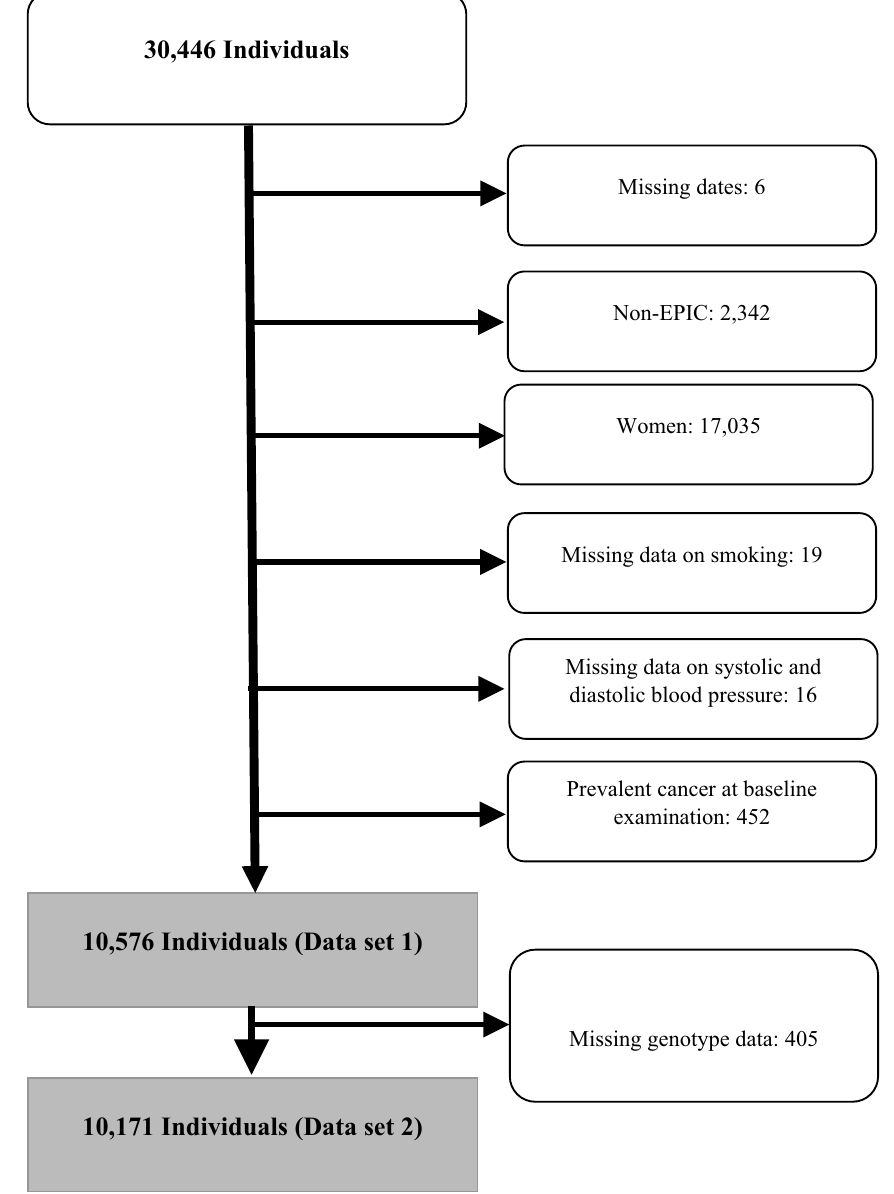
Figure 1. Flow chart showing the selection of the study participants. Data set 1 was used for associations between the blood pressure indices and urothelial carcinoma (UC) outcomes. Data set 2 was used for association between the weighted genetic risk score for bladder cancer and UC outcomes and the interaction